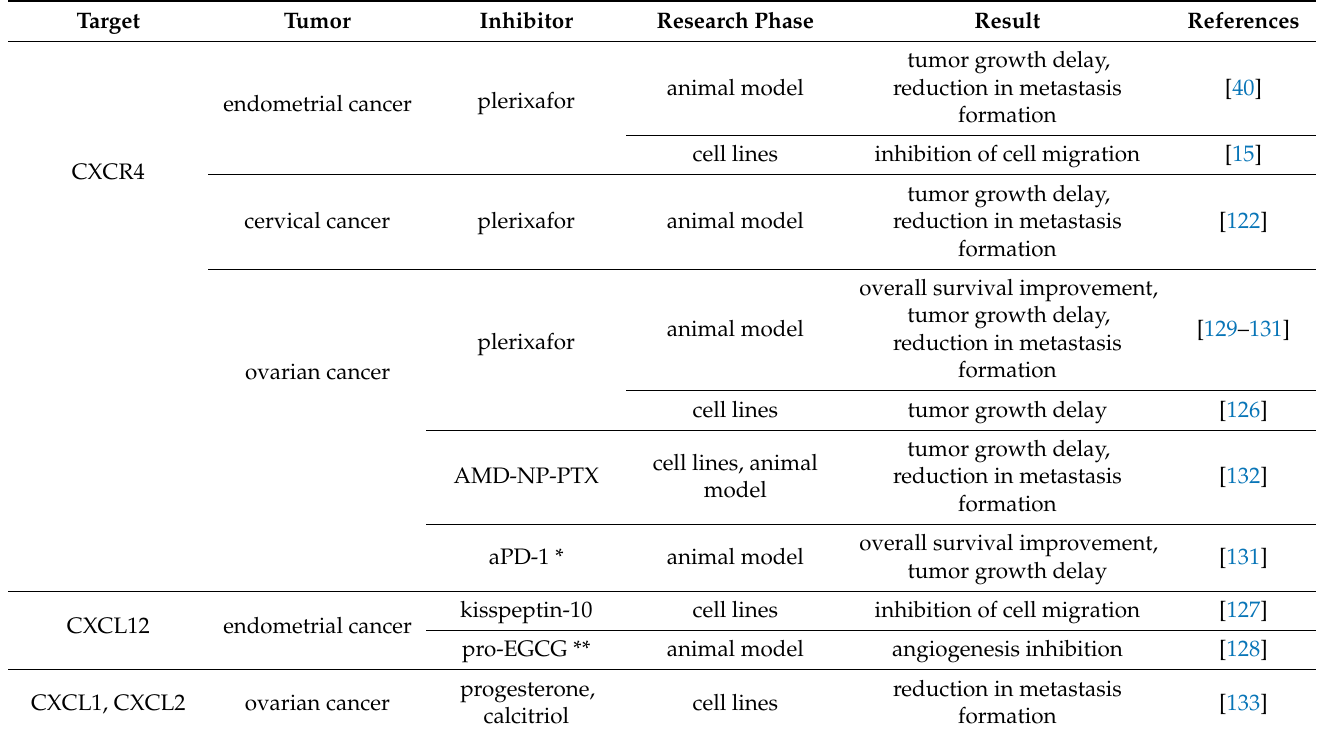
Table 1. Summary of chemokine inhibition effects in gynecological malignancies in preclinical studies. * aPD-1—anti-programmed death receptor 1 antibody, ** pro-EGCG—prodrug of green tea polyphenol ( −